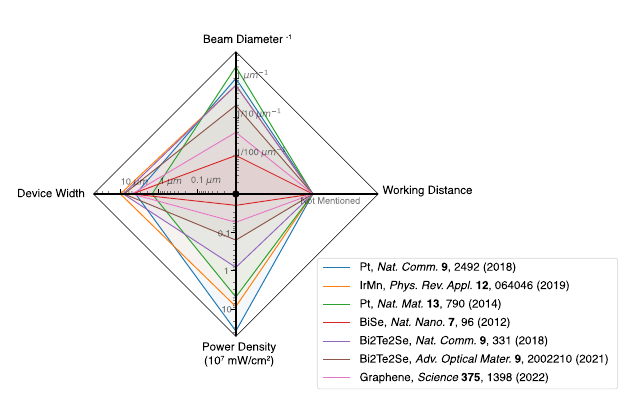
Fig. 4 | Graphical representation of the experimental parameters driving the beam shift-induced photoresistance. Different material systems including metals, topological insulator, semimetals are selected from published works. The laser spot diameter, device width, and laser power are radar plotted for compar- ison. It is important to note thatthe working distanceusedinthese experiments is not mentioned. For this reason, we assigned the same value for all. The beam-shift